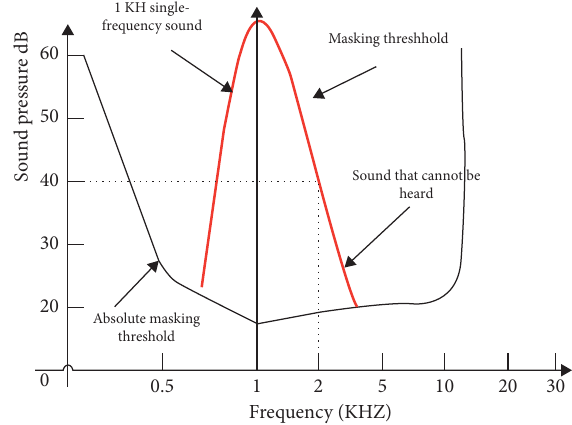
Figure 7: Spectrum masking characteristics.